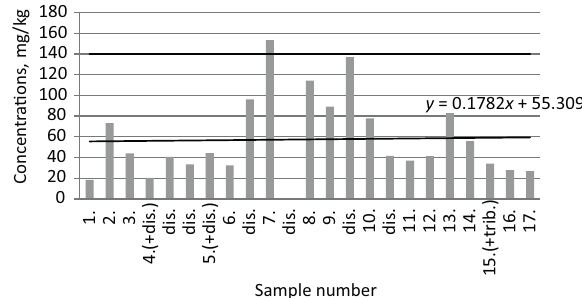
Fig. 8. Cr concentrations on the left bank, downstream trend ( y ), the concentration of the I sludge category (bold line)